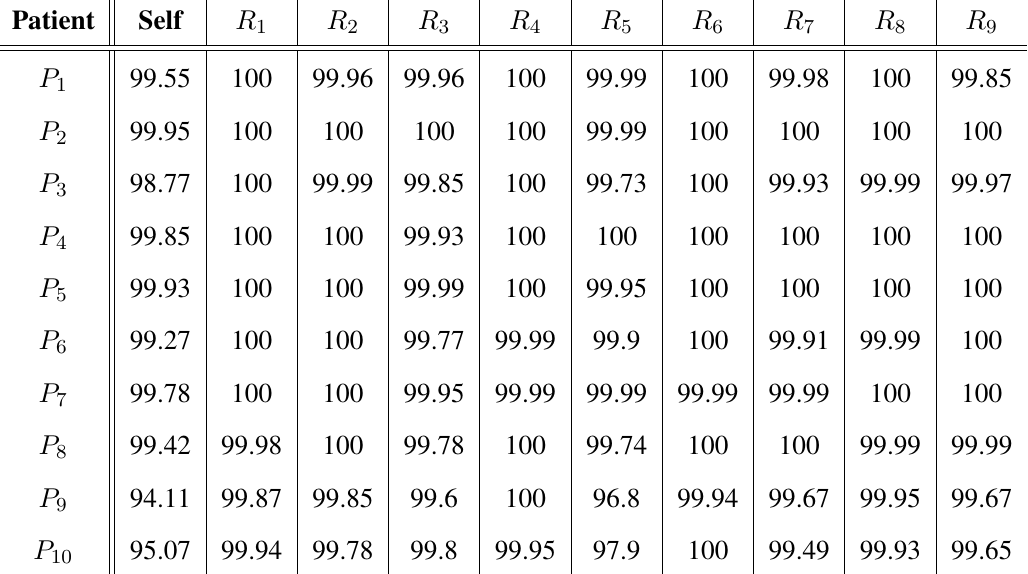
Table 2. Neural network results on training